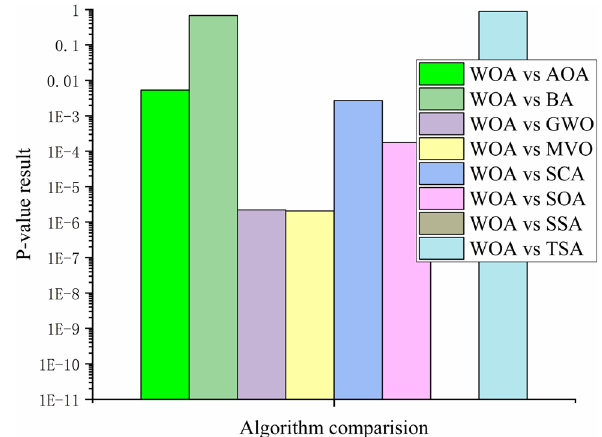
Fig. 16 The p-value test of the algorithms for case 2